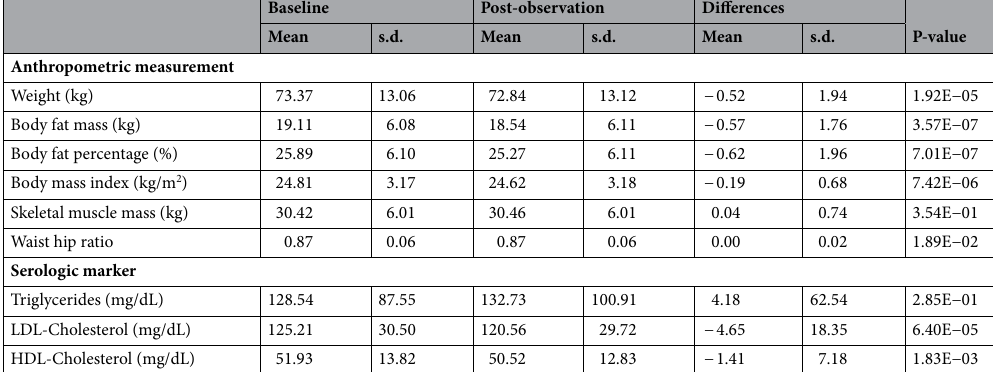
Table 1. Comparison of basic anthropometric and serologic markers of the volunteers between the pre- and post-observation periods. Paired t-test was performed to determine a significant difference between baseline and post-observation period of anthropometric measurements and serologic markers. There were significant differences in weight, body fat mass, body fat percentage, BMI, Waist hip ratio, LDLc, and HDLc.